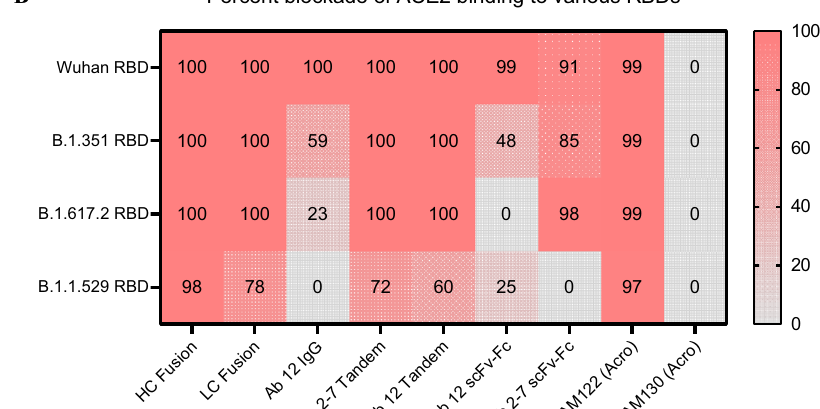
binding to Wuhan, B.1.351, B.1.617.2, and B.1.1.529 RBDs was performed with bioti- nylated RBD proteins and soluble ACE2. Though our BsAbs weakly bind mutant spikes at low concentration, at high concentrations they are able to effectively block ACE2 binding to the RBD. Two chimeric antibodies from Acro Biosystems were used as experimental controls, as both are cross-reactive but only AM122 has been demonstrated to compete with ACE2 binding. The percent binding experi- ment was performed in triplicate and mean values are shown. Competition was performed as a single experiment. Source data are provided as a Source Data fi